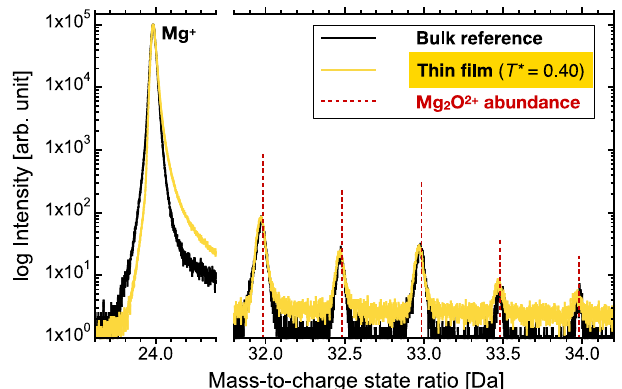
Figure 6. Mass spectrum data of the (Mg,Ca) solid solution grown at T* = 0.40 in comparison to a Mg–1.06Al– 0.046Ca (wt%) bulk solid solution. Both mass spectra were normalised with respect to the maximum intensity of 1 × 10 5 for the 24 Mg + peak. Dashed lines represent the abundance of the Mg 2 O 2+ isotopes. The figure was created with KaleidaGraph 4.5.3 (https:// www. syner gy.